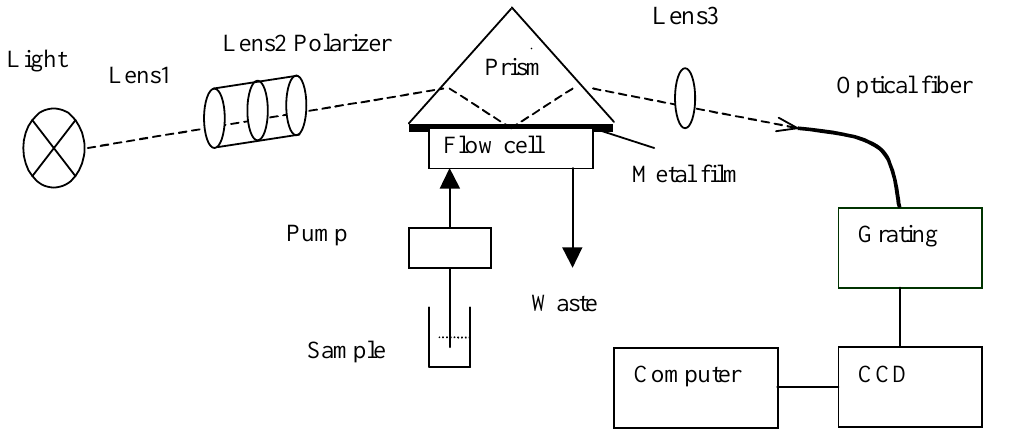
Figure 1. Block diagram of SPR sensor based on simultaneous multi-wavelength